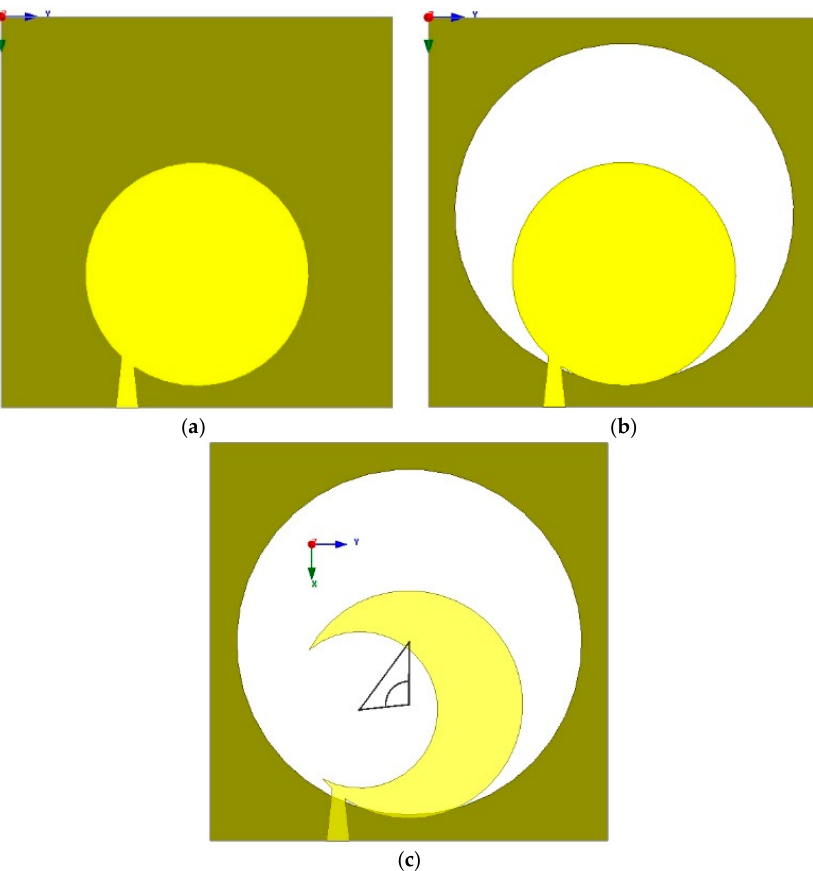
Figure 2. Evolution of design: ( a ) Ant1 ( b ) Ant2, ( c ) Ant3.